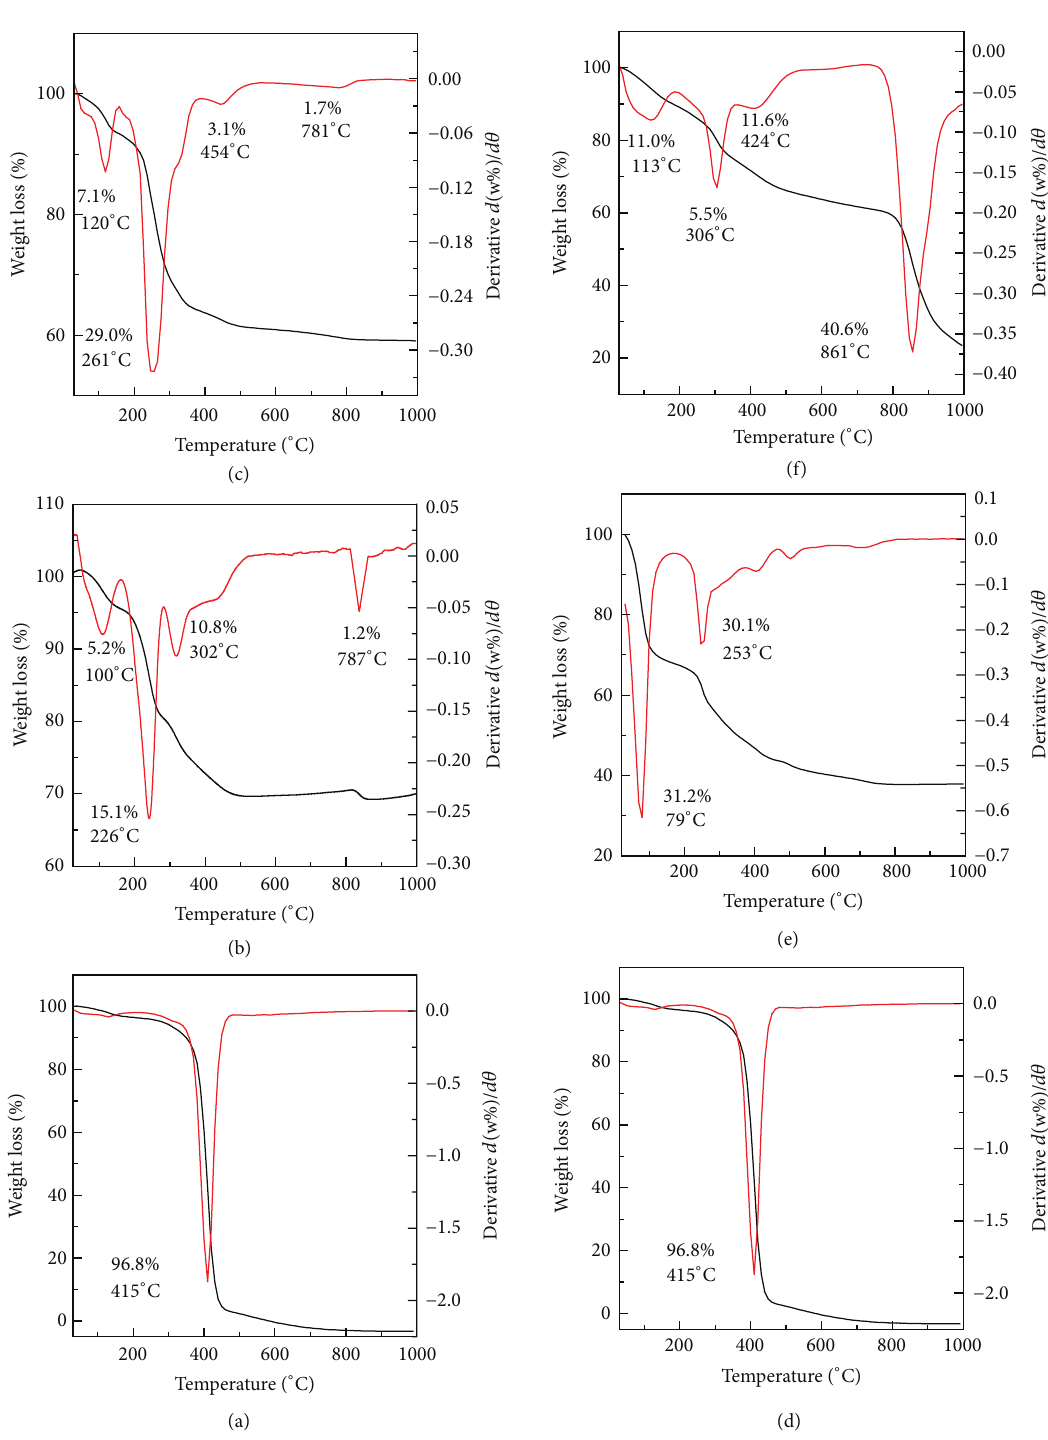
Figure 5: TGA/DTG thermograms of levodopa ((a) and (d)), Zn/Al-LDH (b), tween-LDH (c), dopa-LDH nanocomposite (e), and the tween- dopa-LDH-nanocomposite